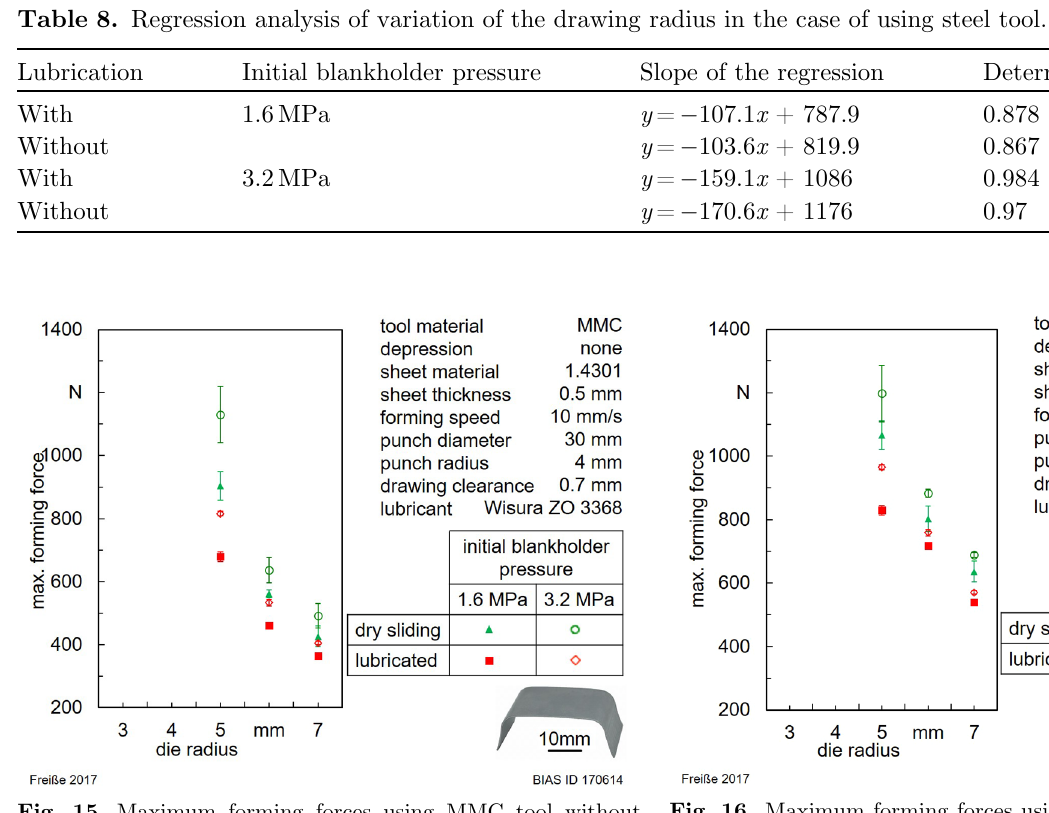
Fig. 15. Maximum forming forces using MMC tool without depression. Table 9. Factors for increasing the forming forces in the case of using MMC tool surface.